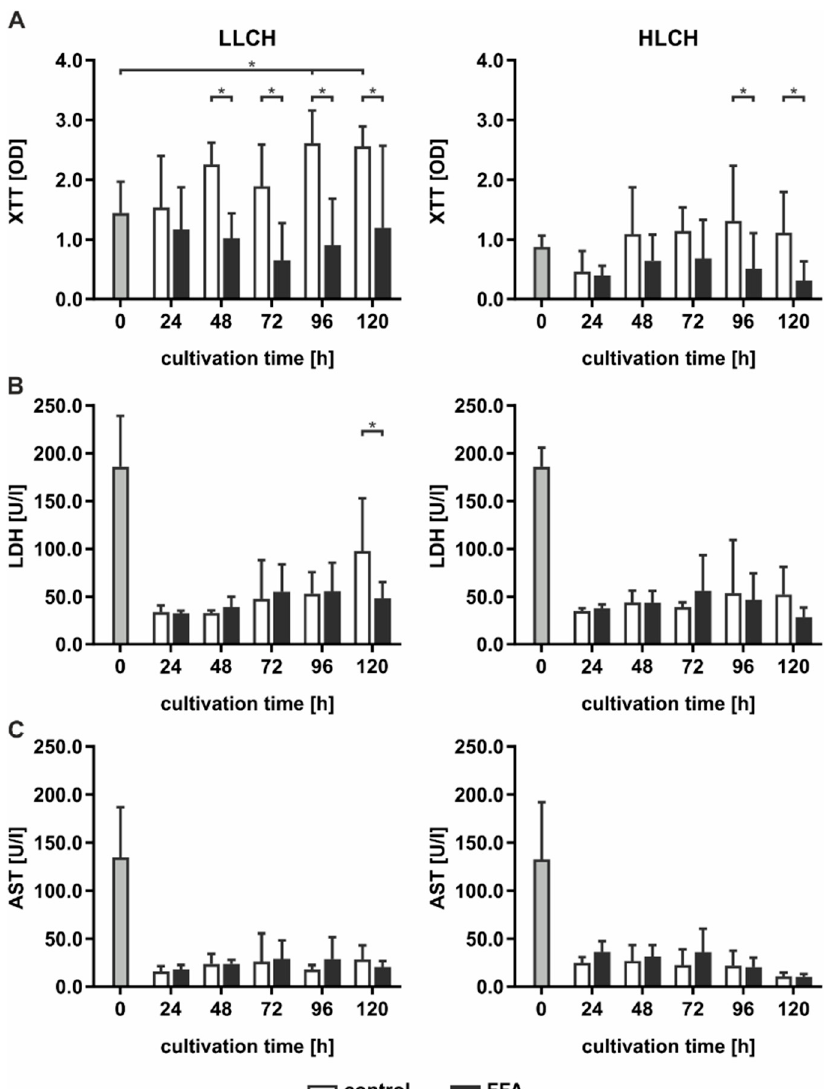
Figure 2. Evaluation of lipid-induced cell death in the LLCH (donors 1–3) and the HLCH (donors 4–6) according to the continuous lipid accumulation for five days. Lipotoxic effects were investigated by measuring cell activity levels using ( A ) XTT (2,3-bis-(2-methoxy-4-nitro-5-sulfophenyl)-2H-tetrazolium-5-carboxanilid) assays, and alterations to membrane integrity using extracellular ( B ) LDH (lactate dehydrogenase) and ( C ) AST (aspartate transaminase) enzyme activities. Data are shown as the means ± SD, n = 3, two-way ANOVA, and post hoc Dunnett or Bonferroni analysis. A p value of 0.05 or less (*) was considered significant. Selected comparisons are shown; for details on the statistical evaluation, see Table S1B.